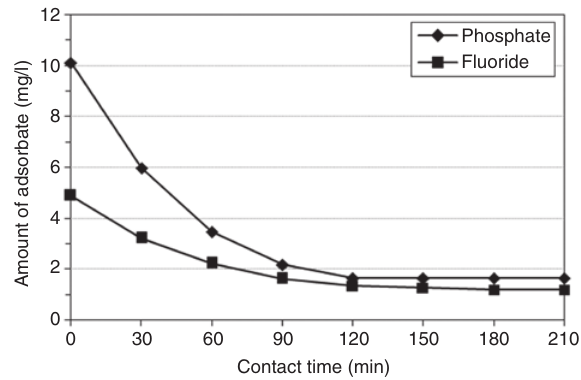
Figure 4: Determination of adsorption equilibrium